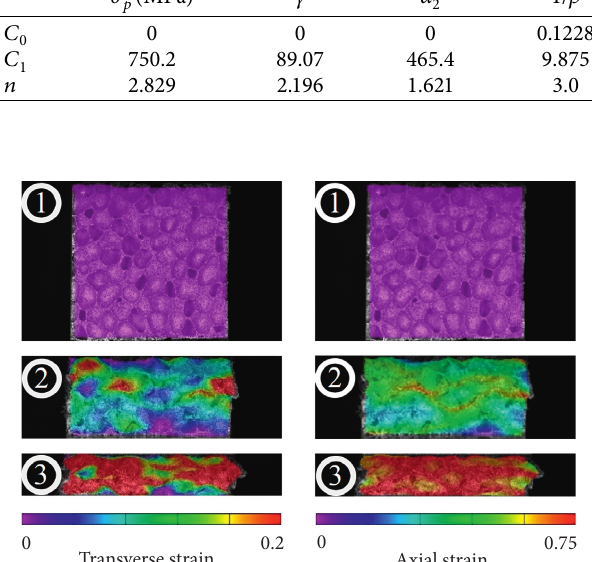
Figure 6: Axial and transverse nominal strain contour maps obtained via DIC technology.